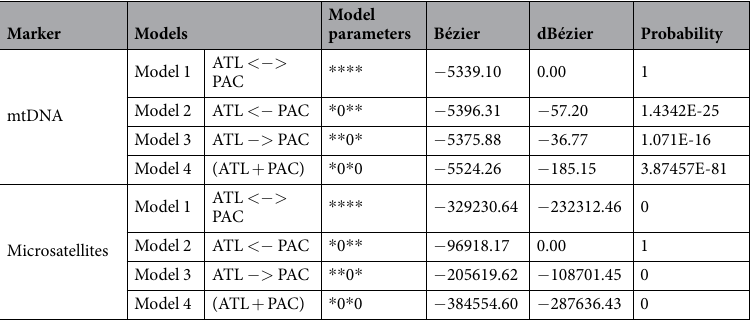
Table 2. Bayes factors model comparison of migration models for Old World Anchovies between the Atlantic (ATL) and the Pacific (PAC) oceans. Model parameters code as follows: asterisk ( * ) indicates that a particular migration rate was estimated by the model and 0 indicates that no migration was allowed. The first sign indicates theta for Atlantic, the second sign migration to Atlantic, the third sign theta for Pacific and the forth sign migration to Pacific.